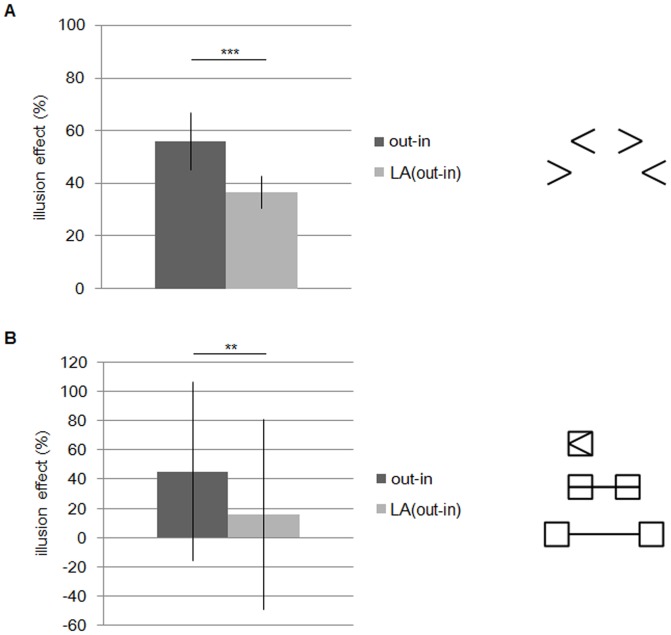
(a) The illusion effect in the ant foraging model for the variant of Müller-Lyer figures (wings-out/wings-in vs. large angled wings-out/wings-in) where central shaft is removed.(b) The illusion effect in the ant foraging model for the variants of the Müller-Lyer figure, where arrow head or tail is replaced by a box.